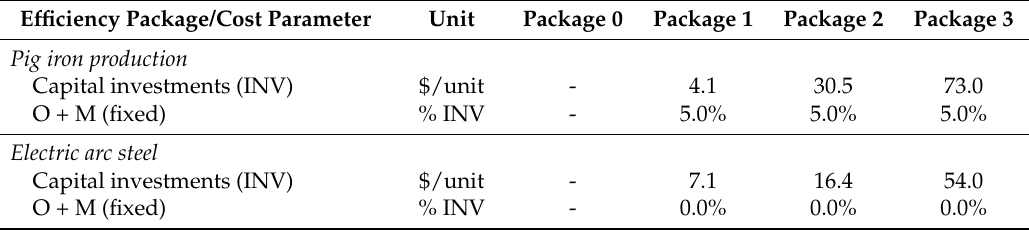
Table A3. Cost parameters for the energy efficiency packages discussed in the text above. Since no technological cost learning effect is assumed, these cost parameters are used also for